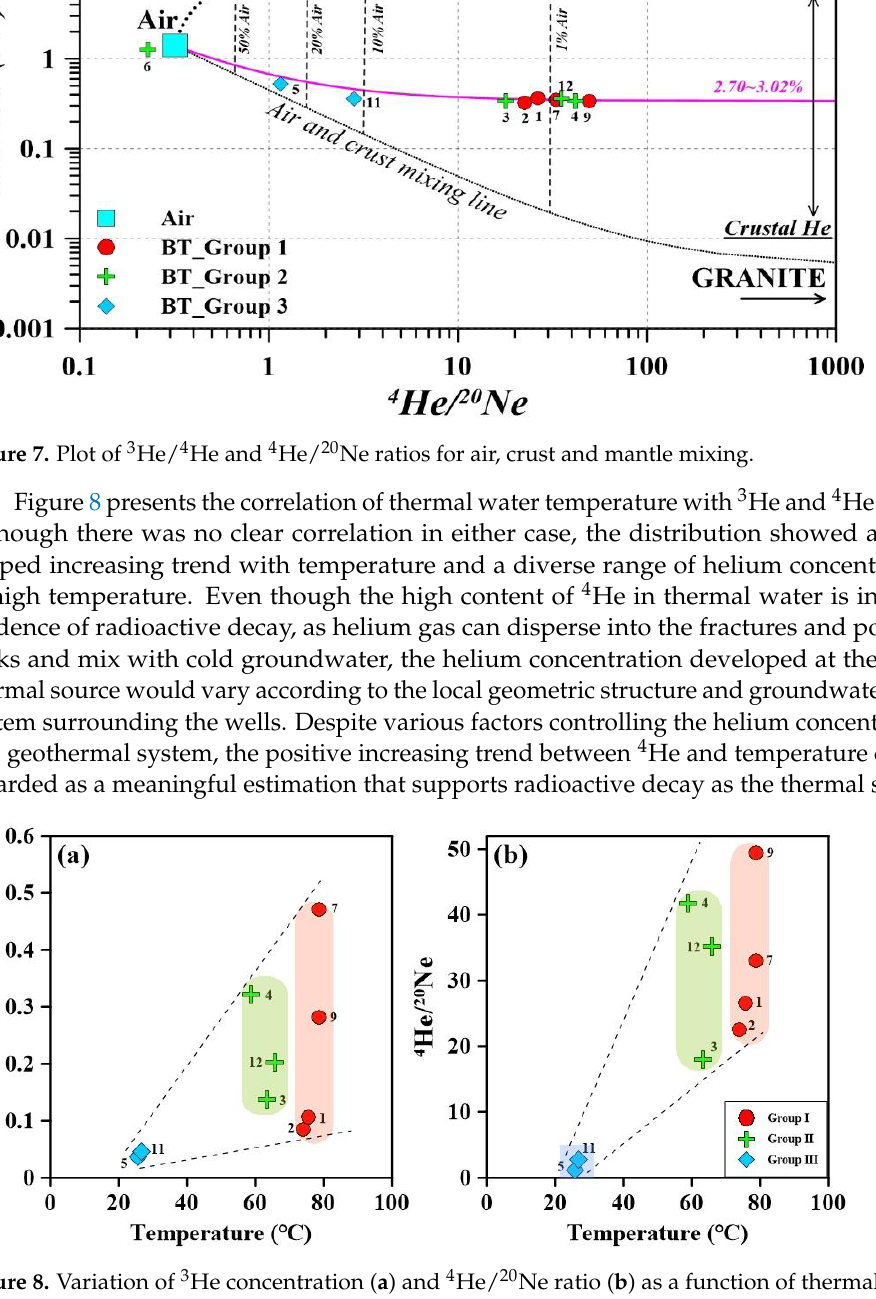
Figure 8. Variation of 3 He concentration ( a ) and 4 He/ 20 Ne ratio ( b ) as a function of thermal water temperature. Table 3. Original content ratio of 3 He and 4 He in Bugok thermal waters.